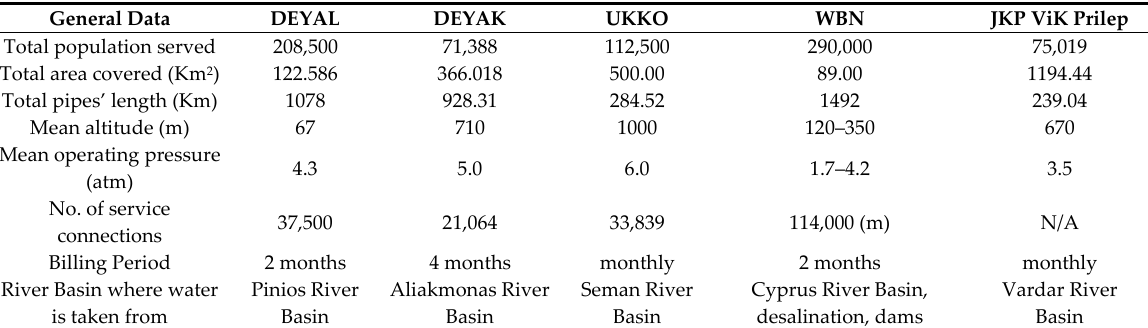
Table 2. General information for the Water Utilities